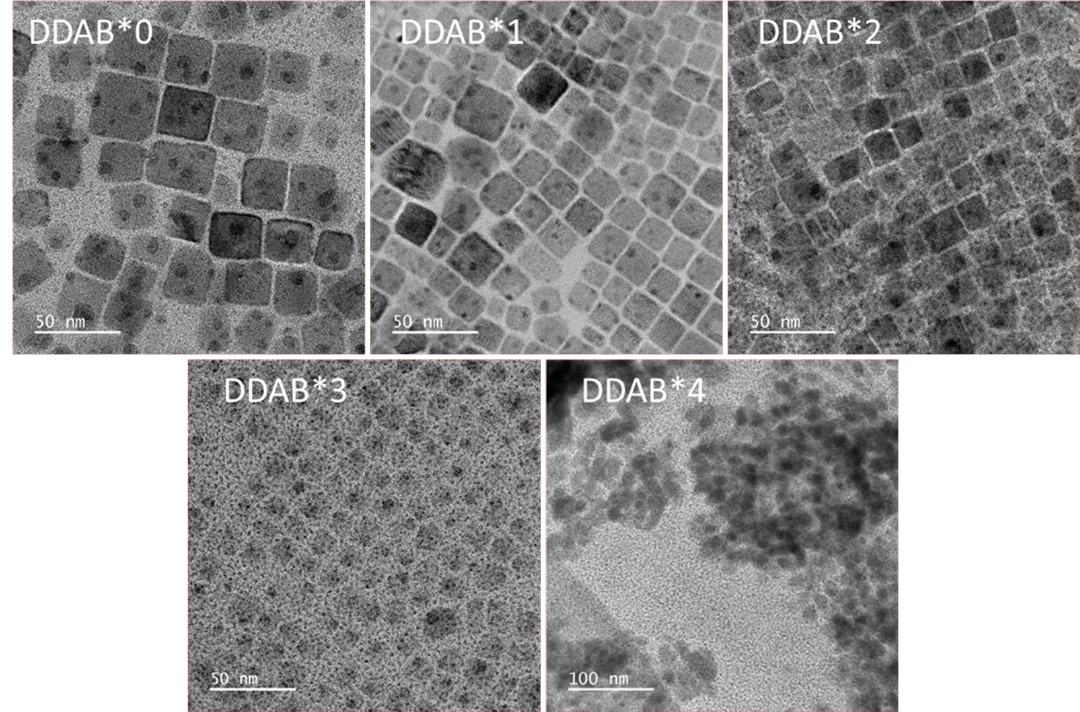
Figure 2. TEM images of CsPbCl x Br 3−x PQDs treated by different DDAB concentrations.